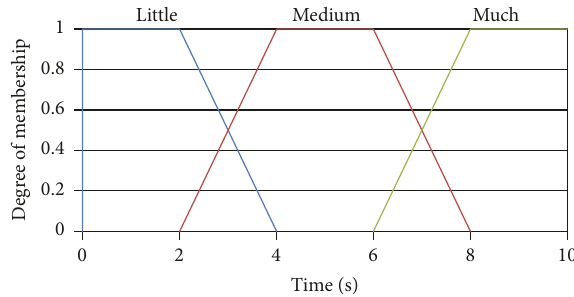
Figure 11: Labels for the temporary variable ( T